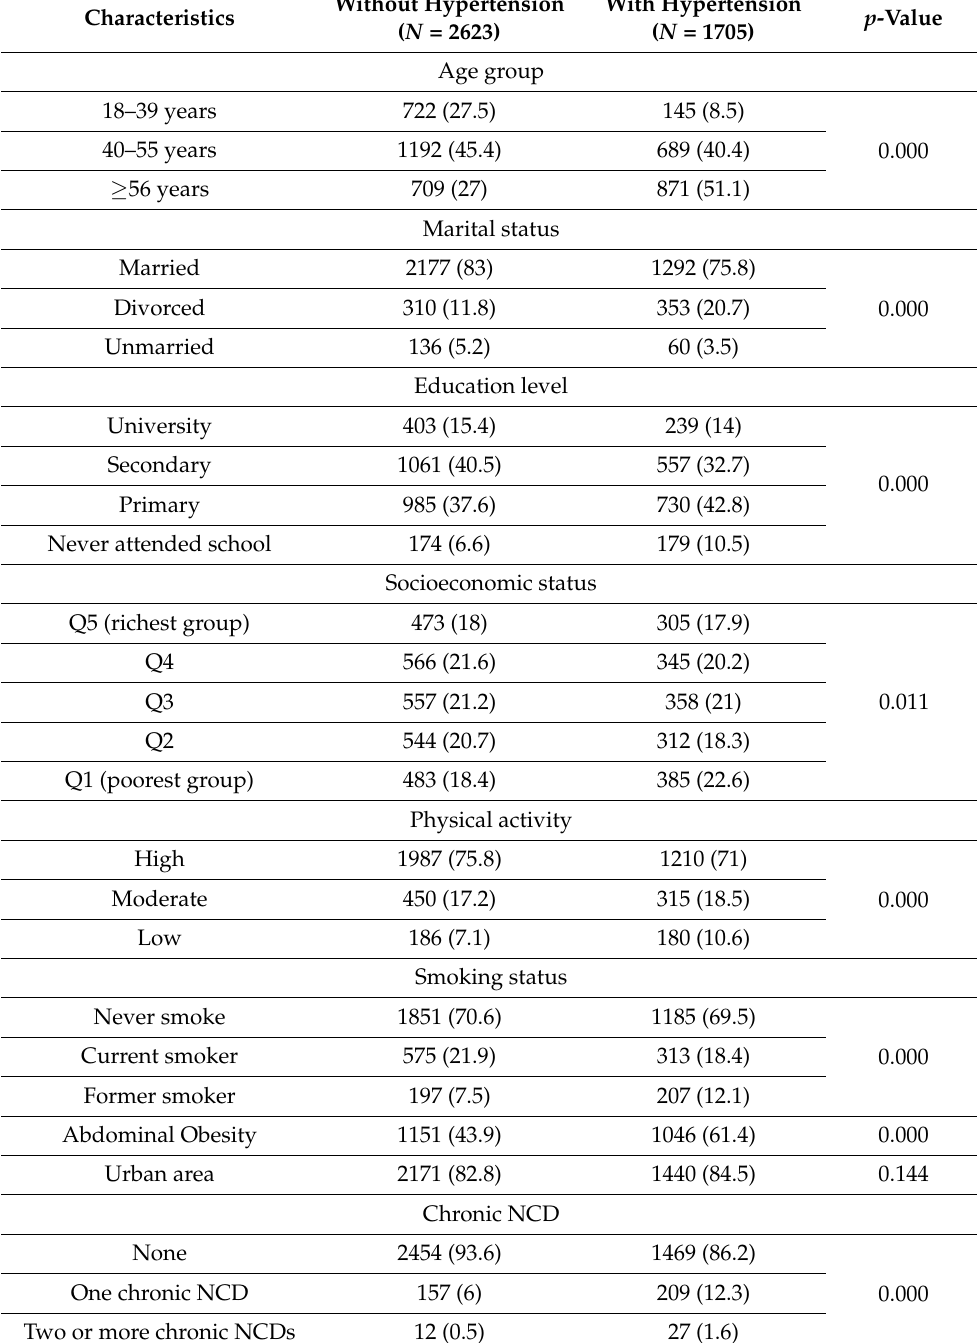
Table 2. Characteristics of HDSS respondents in 2018, by hypertension